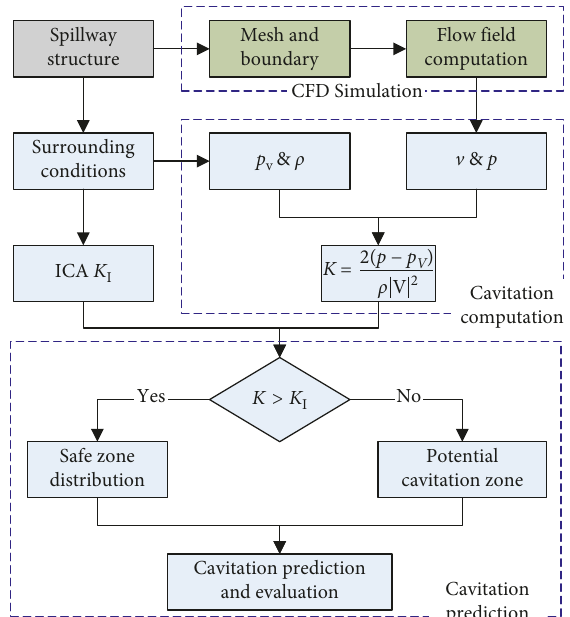
Figure 2: Flowchart for cavitation